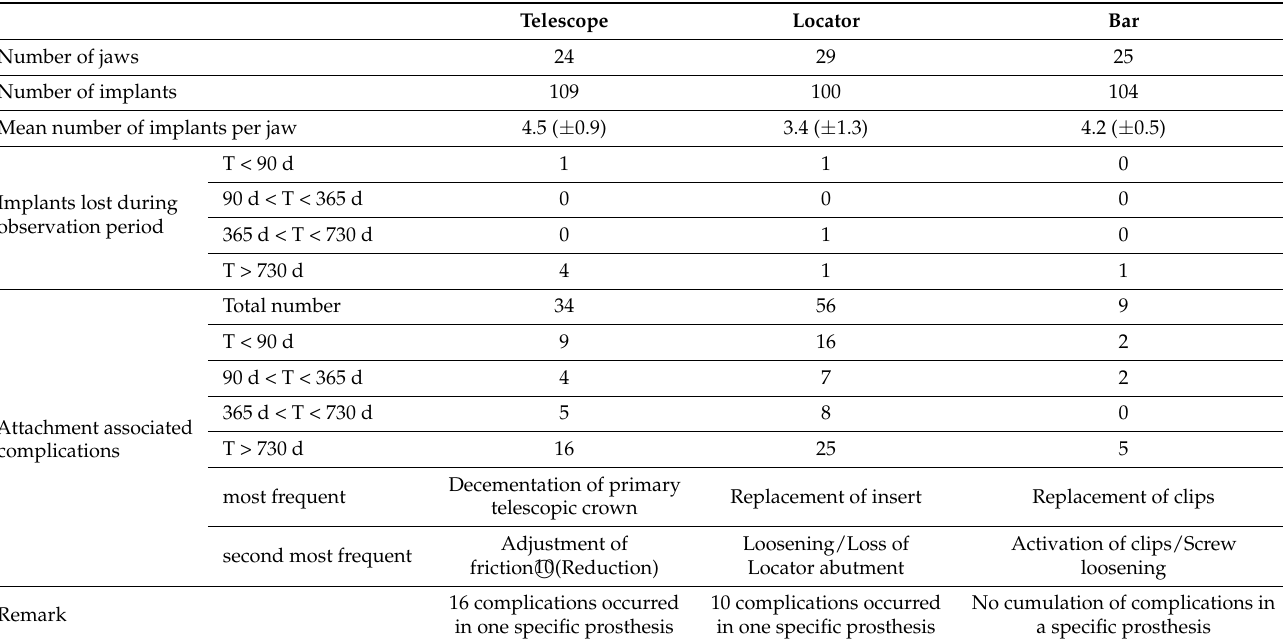
Table 1. Results of retrospective patient